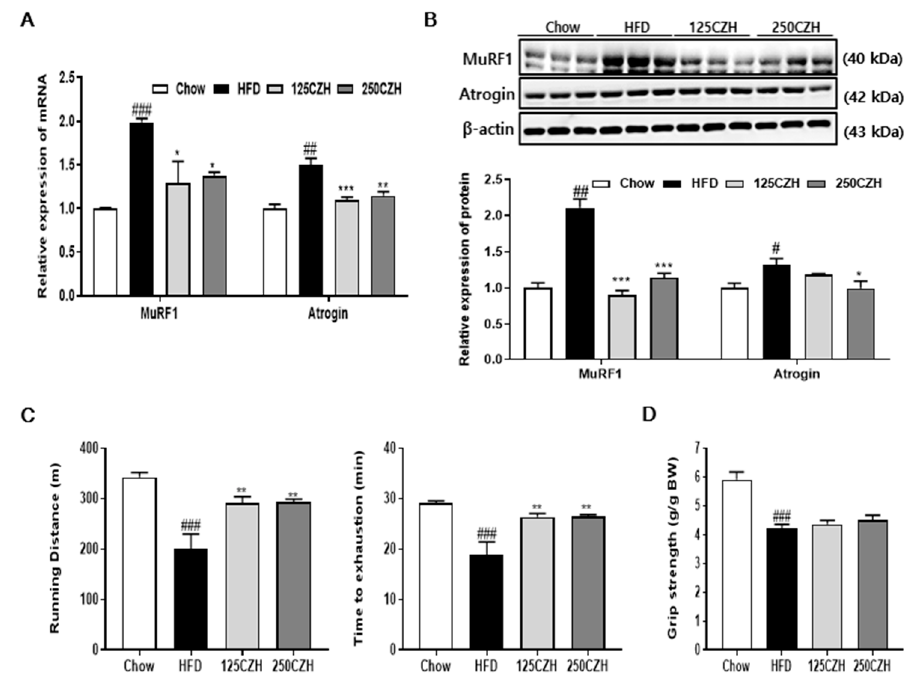
Figure 2. Effect of CZH on obesity-induced skeletal muscle atrophy in HFD-fed mice. ( A ) Expression levels of muscle atrophy-related genes muscle RING-finger protein 1 (MuRF1) and Atrogin in quadriceps muscle quantified by qRT-PCR. ( B ) Expression levels of MuRF1 and Atrogin in gastrocnemius muscle quantified by Western blotting. Band density was analyzed using ImageJ software. ( C and D ) Exercise capacity was measured according to running distance (m), time (min), and grip strength (g/g BW). Results are expressed as mean ± SEM ( n = 8). * p < 0.05, ** p < 0.01, *** p < 0.001 versus the HFD group. # p < 0.05, ## p < 0.01, ### p < 0.001 vs. the Chow-fed group.